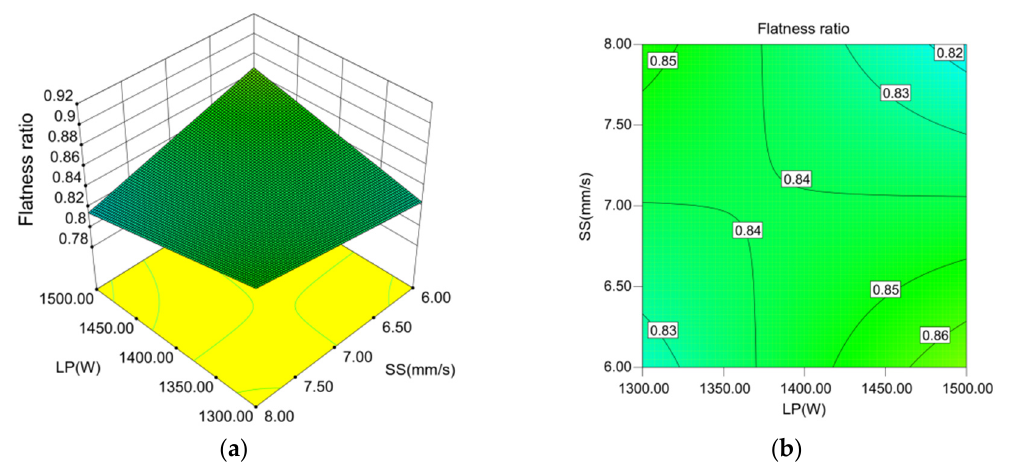
Figure 4. ( a ) Response surface of laser power and scanning speed interaction affecting the flatness ratio; ( b ) Contour line of the response surface.